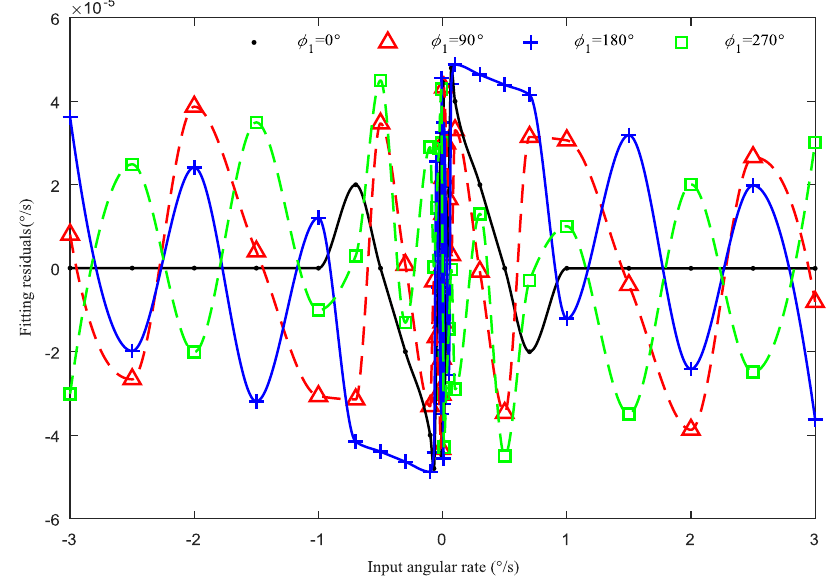
Figure 11. Fitting residuals of angular rate under 1 µ m–0 ◦ , 90 ◦ , 180 ◦ , and 270 ◦ uneven capacitance gap.